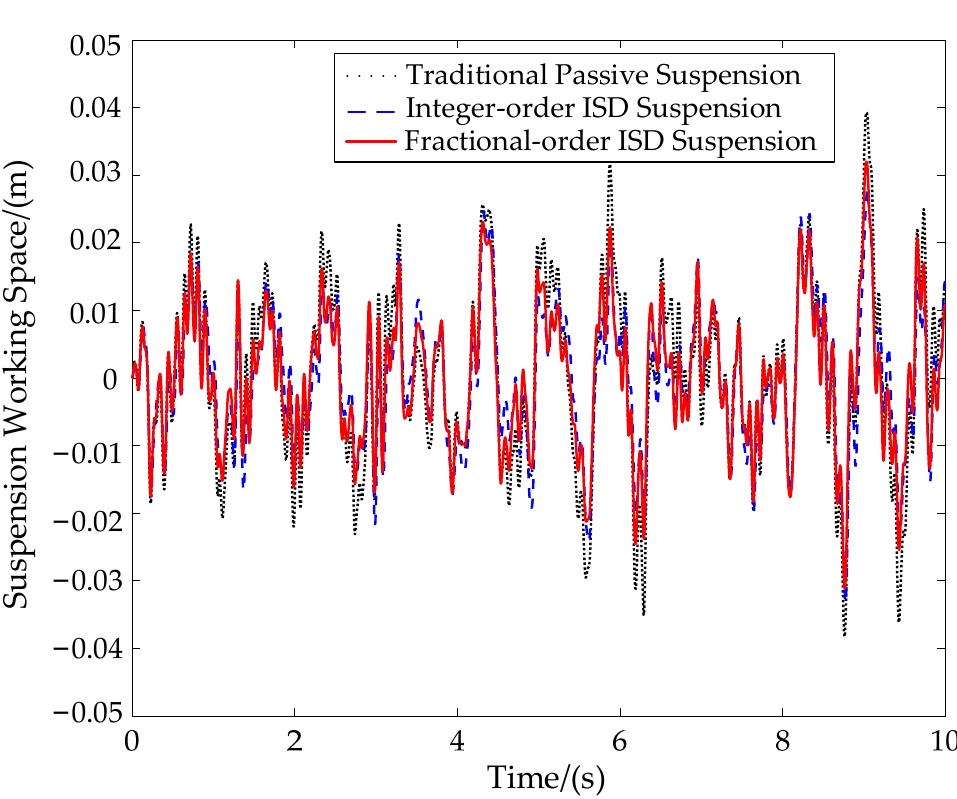
Figure 8. Comparison of the vehicle body acceleration.